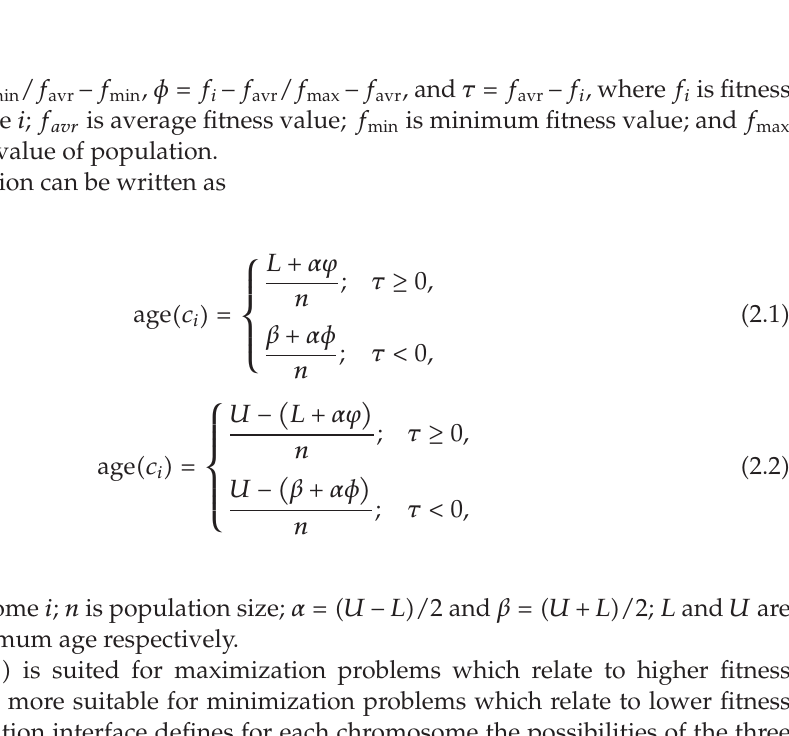
Figure 3: The membership function for male and female